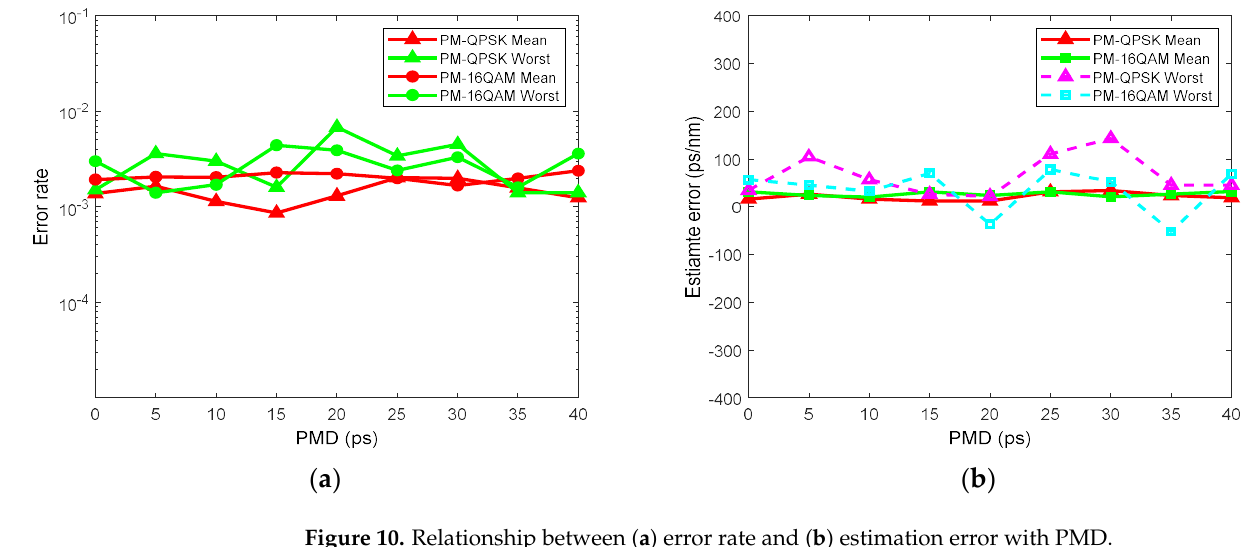
Figure 10. Relationship between ( a ) error rate and ( b ) estimation error with PMD.